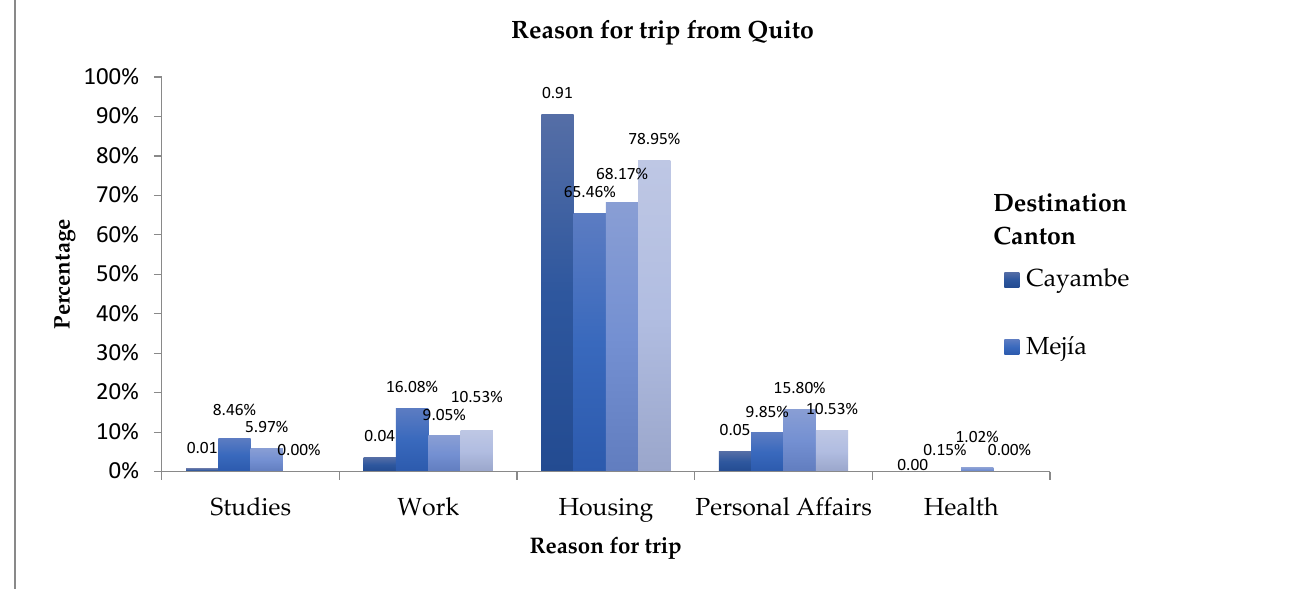
Figure 7. Reason for traveling to and from Quito, from and to cantons NAMQ (Quito Metro, 2011).